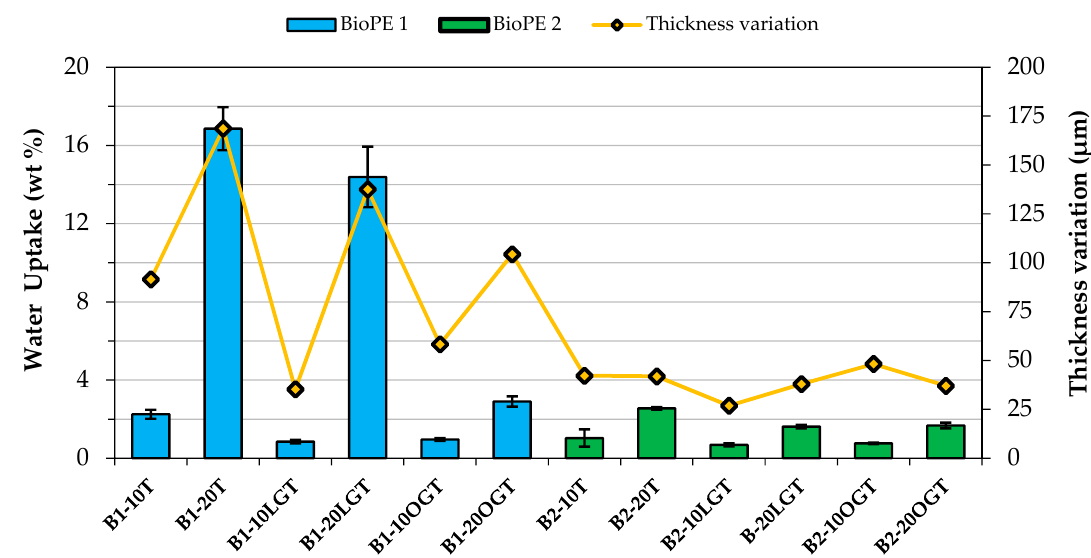
Figure 8. Water uptake (blue/green columns) of the biocomposite filaments after 32 days of water immersion (left axes). The thickness variation (yellow line) of the biocomposites is given in the right axis.